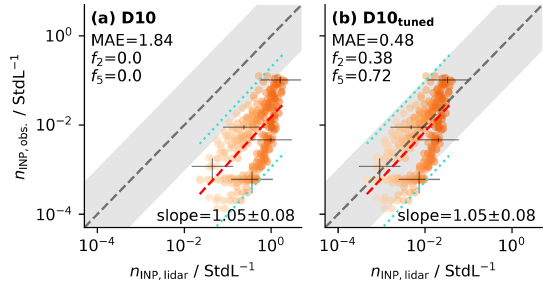
Figure 7. Same as for Fig. 4 but comparing in situ INP concen- trations ( n INP , obs . ) measured at WFJ (mountaintop site, Fig. 1) to lidar-retrieved INP concentrations ( n INP , lidar ) using (a) the standard D10 parameterization and (b) the tuned D10 parameterization (see Eq. 11) for continental aerosol. Note that (a) is the same as Fig.